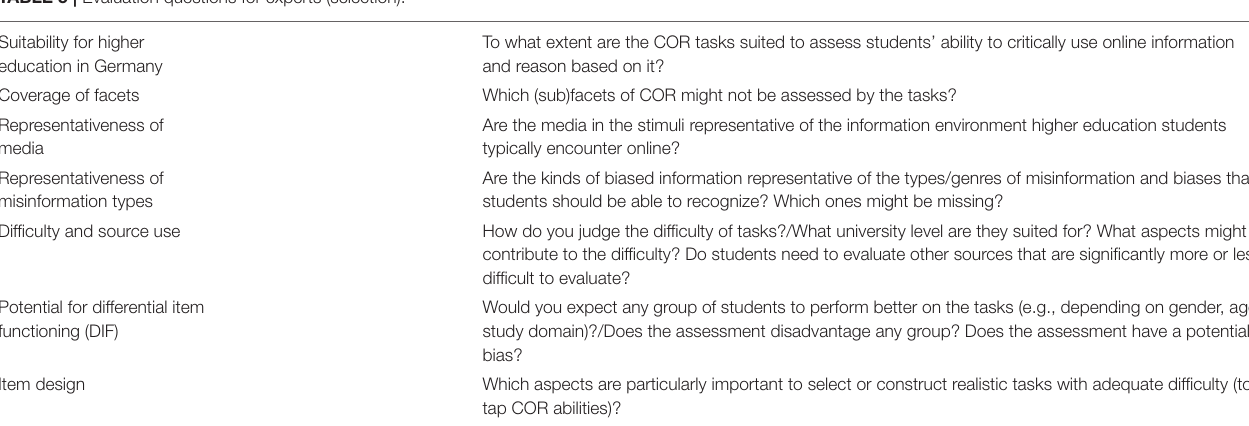
TABLE 5 | Evaluation questions for experts